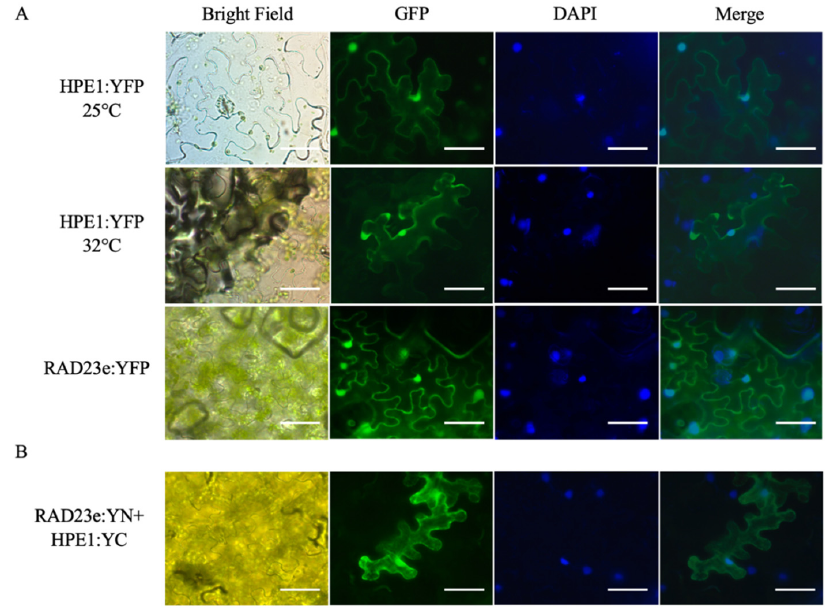
Figure 3. ( A ) HPE1B and RAD23e colocalized at the nuclei and cytosol of Nicotiana benthamiana epidermal cells. Upper panel: HPE1B:YFP:HA at 25 ° C; Middle panel: HPE1B:YFP:HA at 32 ° C; Lower panel: SlRAD23e:YFP:HA at 25 ° C. Scale bar = 50 µm ( B ) Bi-molecule fluorescence complementation (BiFC) analysis of HPE1B and RAD23e interaction in N. benthamiana epidermal cells infiltrated with a 1:1 ratio of agrobacteria containing HPE1B-YC and RAD23e-YN. Images were taken between 48–60 h postinfiltration.